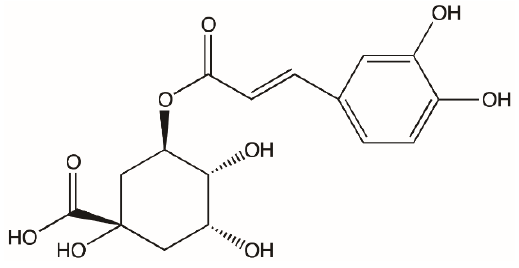
Figure 1. Structure of chlorogenic acid.